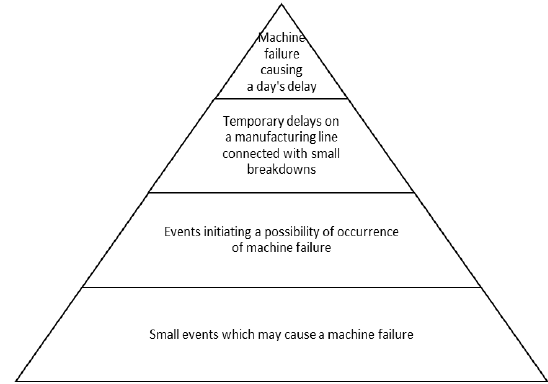
Figure 2: Pyramid of potential events in a machine failure Source: B. Eckhardt [28]